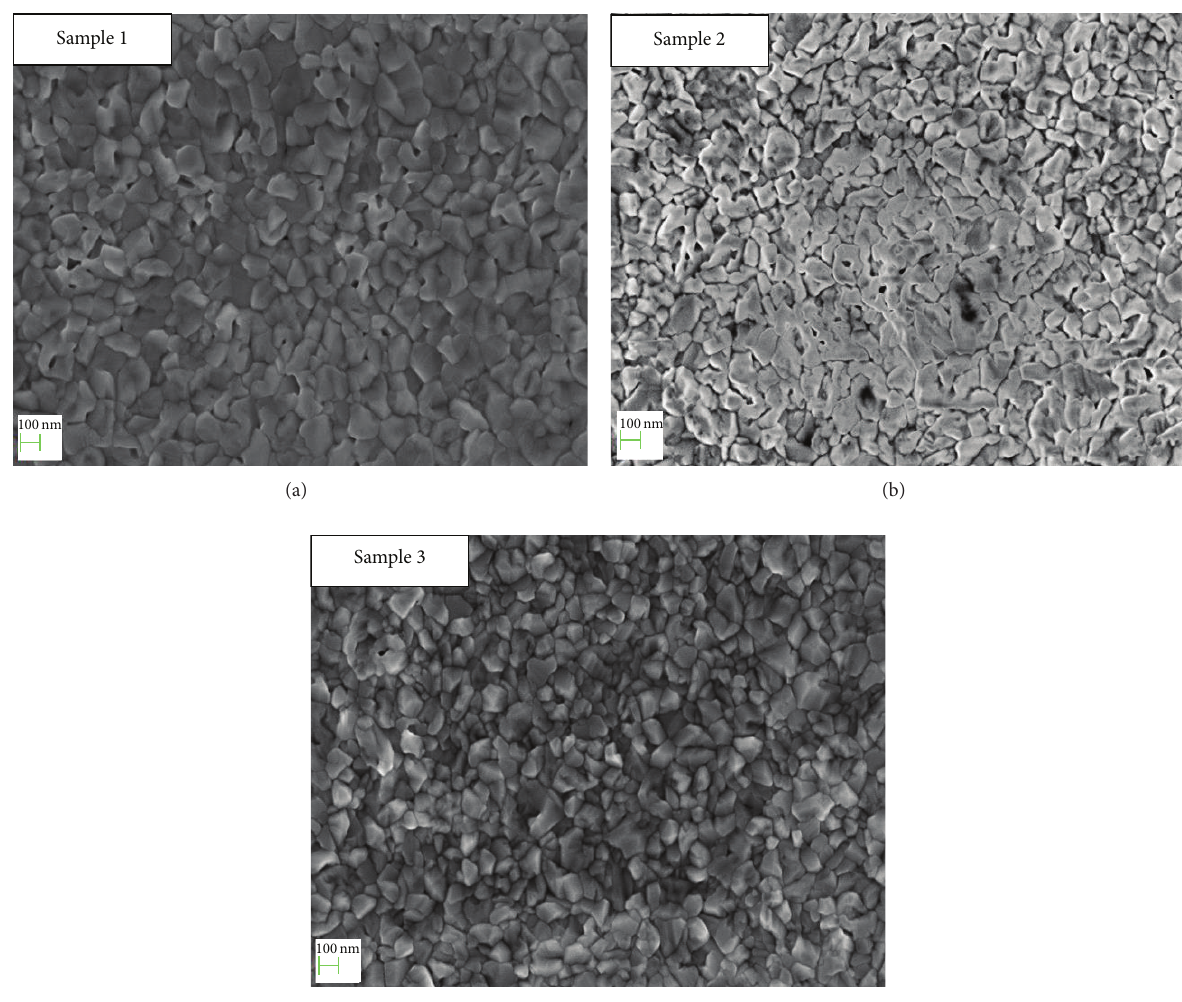
Figure 2: FESEM micrographs of cuprous oxide thin films with irregular grain